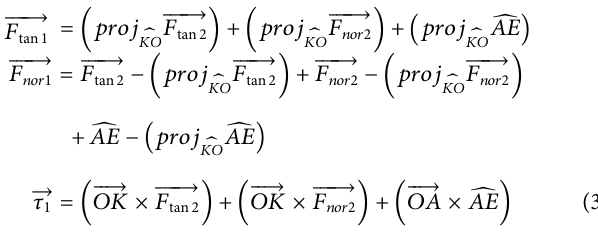
Frontiers in Bioengineering and Biotechnology |